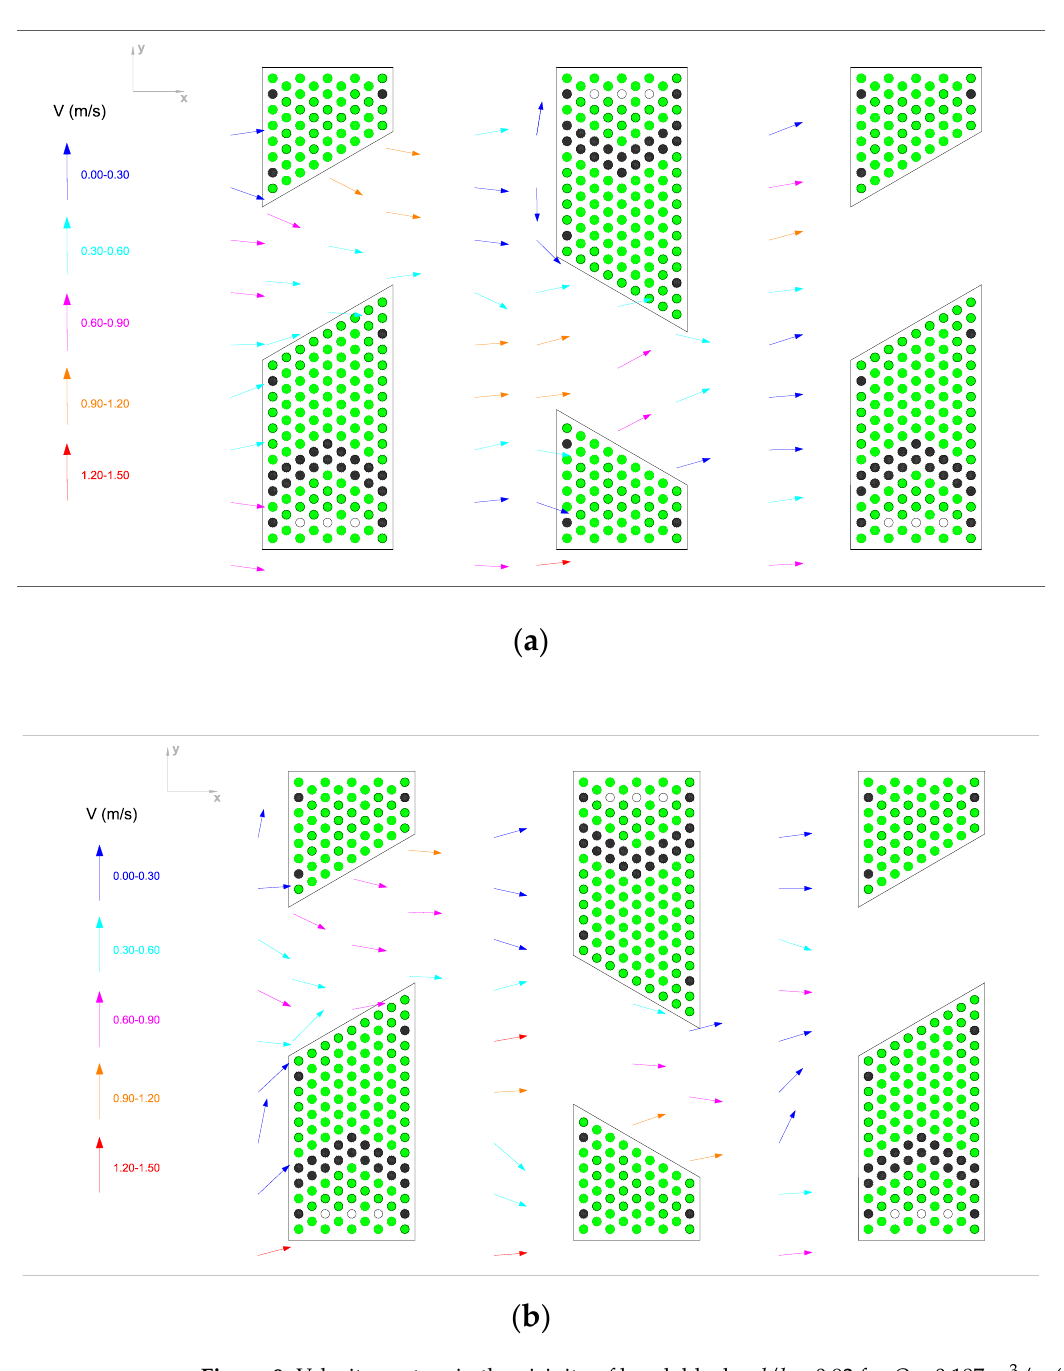
Figure 9. Velocity vectors in the vicinity of brush blocks, d/h = 0.92 for Q = 0.187 m 3 /s: ( a ) z/d = 0.60 and ( b ) z/d = 0.15.